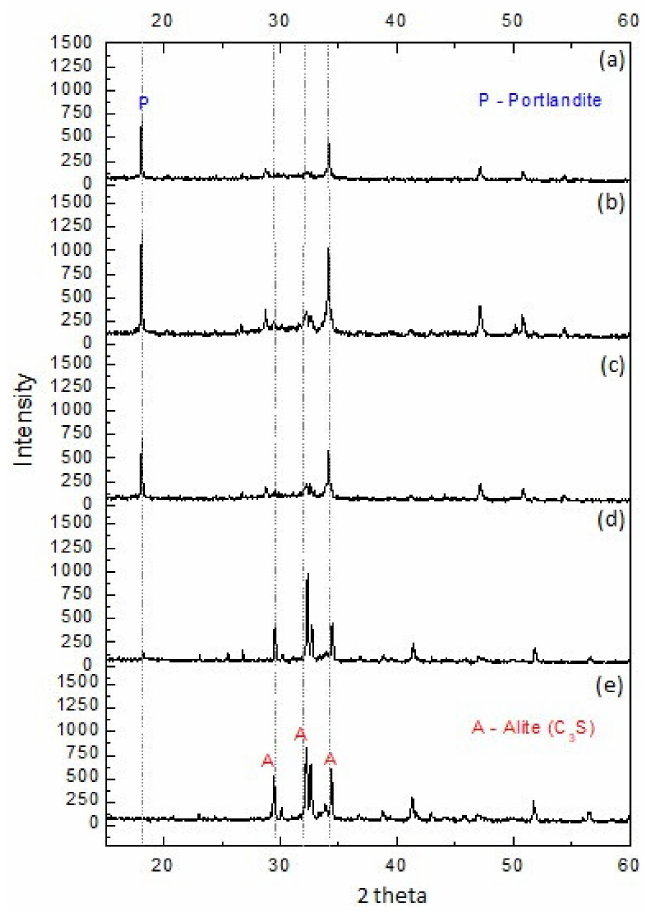
Figure 17. X-ray di ff ractometry (XRD) for evaluated samples: STD ( a ), cement slurry / system 3 ( b ), cement slurry / system 2 ( c ), cement slurry / system 1 ( d ) and anhydrous cement ( e